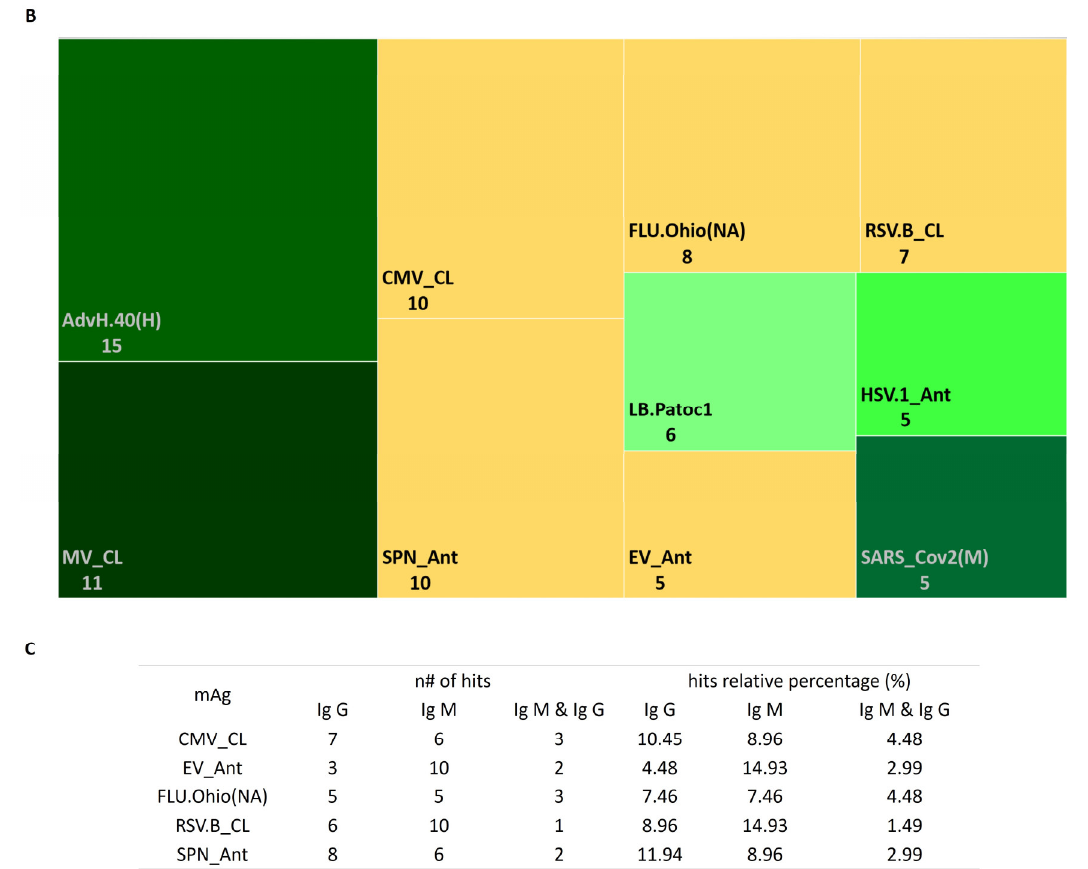
Figure 3. Quantitative summary of top 10 microbial antigens (mAgs) detected in this study: ( A ) mAgs detected by IgG antibodies (Abs) in the studied cohort; ( B ) mAgs detected by IgM Abs in the studied cohort; ( C ) number ( n #) and percentage (%) of samples for each detected mAg with respect to the total studied cohort.